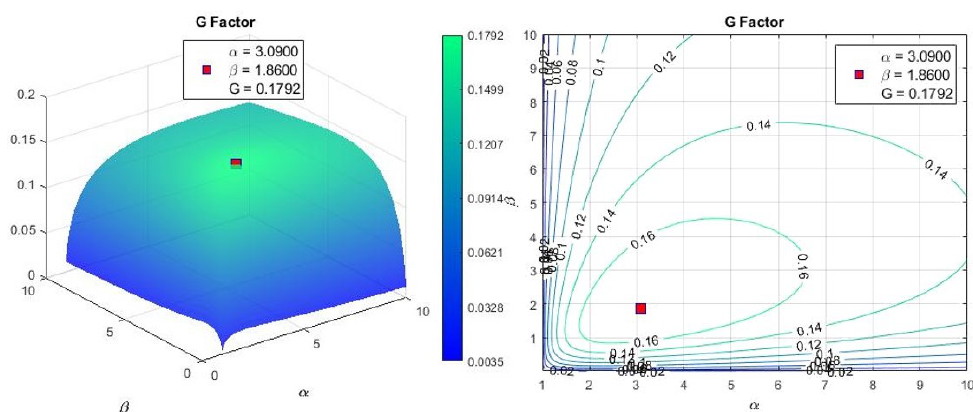
Figure 3. Ideal Fabry factor values for minimizing heat